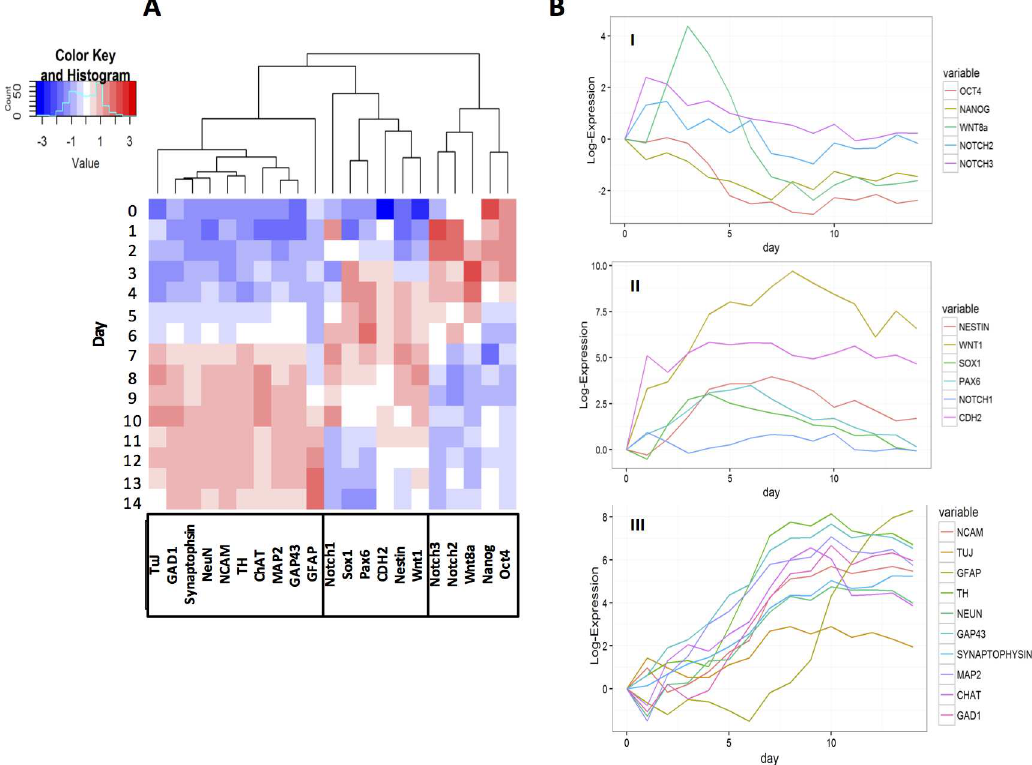
Fig 2. Gene expression trajectoryover two weeks of differentiation. (A) Heatmap of the standardizedexpression trajectories for genesover a two-week co-culture of mESCs andPA6cells. The genes fall into 3 different clusters that represent genes associated with pluripotency, neuralprogenitorcells, and specific neuralcells. (B) Temporal log2-expression (non-standardized)levels for genes from each of the three clusters.